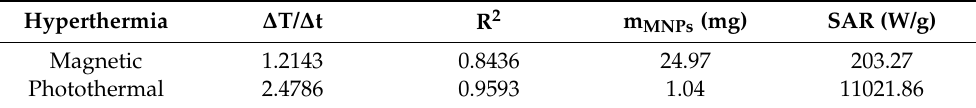
Table 3. Slope ( Δ T/ Δ t), coefficient of determination (R 2 ), nanoparticles’ mass (m MNPs ) and SAR value obtained by magnetic and photothermal hyperthermia.